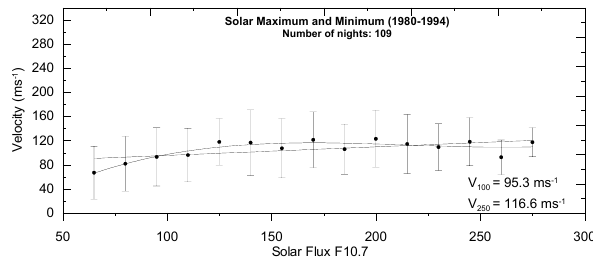
Figure 4. Plasma bubble zonal drift velocities (109 nights of experiments) versus the Solar Flux F10.7, in the interval between 18LT and 22:45LT. Fig. 4. Plasma bubble zonal drift velocities (109 nights of experi- ments) versus the Solar Flux F10.7, in the interval between 18:00 LT and 22:45